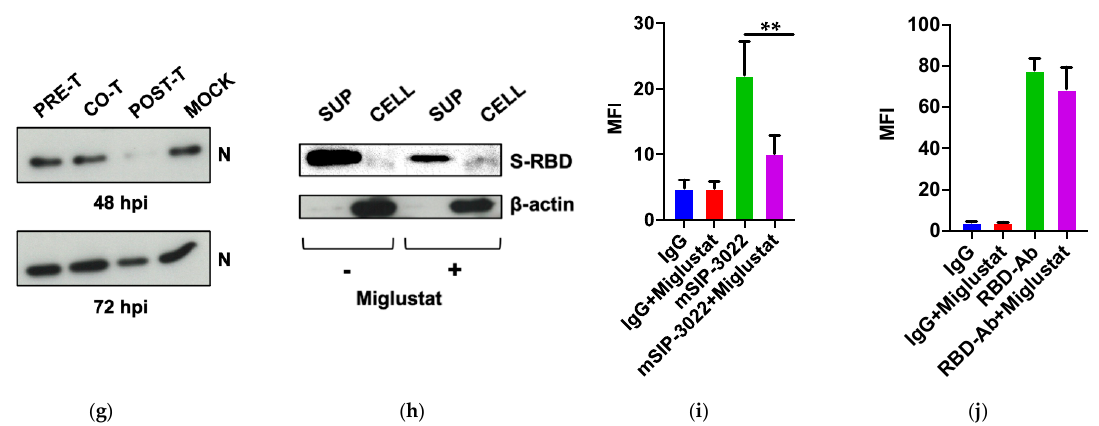
Figure 2. Time of addition studies and the role of Spike. ( a ) Time-of-addition experiment: SARS-CoV-2 genomic RNA. Huh7 cells were infected at moi = 0.1 and incubated with Miglustat before infection (pre-treatment), during infection (co-treatment), and after infection (post-treatment) as described in the text. At the indicated time points, the total RNA was extracted from the infected cells and analysed by RT qPCR. The data are shown as fold-change normalized to their respective T0 values. ( b ) Time-of-addition experiment: SARS-CoV-2 proteins. Protein extracts from Huh7 cells treated as in ( a ) were immunoblotted with a COVID-19 convalescent human serum. The N protein is indicated with Vimentin as the loading control. ( c , d ) Time-of-addition experiment: SARS-CoV-2 infectious virus. The infectious virus produced in the experiment was measured as PFU/mL on Vero E6 cells as indicated. ( e , f ) Time-of-addition experiment: SARS-CoV-2 secreted genomes. The SARS-CoV-2 genomes in the supernatant of infected cells were quantified by RT qPCR as indicated. ( g ) Time-of-addition experiment: SARS-CoV-2 secreted virions. The virion protein N of secreted SARS-CoV-2 was detected with a convalescent human serum. The loading controls are shown in Figure 2b showing the cell extract results of infected cells. ( h ) Secretion of SARS-CoV-2 Spike RBD. The his-tagged Spike-RBD was expressed for 24 h in HEK-293T cells in the presence of Miglustat and protein detected by immunoblot for the his-tag both in supernatant and cell extracts with β -actin as the loading control. ( i , j ) Surface expression of SARS-CoV-2 Spike. Full-length SARS-CoV-2 Spike was expressed in HEK-293T cells for 24 h in the presence of Miglustat and its expression and correct folding on the cell surface was detected with the mSIP-3022 antibody ( i ) or with the anti RBD antibody MAB10540 ( j ). The control was incubated with the secondary antibody only (IgG). Significant p -values are indicated by ** p < 0.01 highly significant; * p < 0.05 significant, measured with a paired two-tailed t